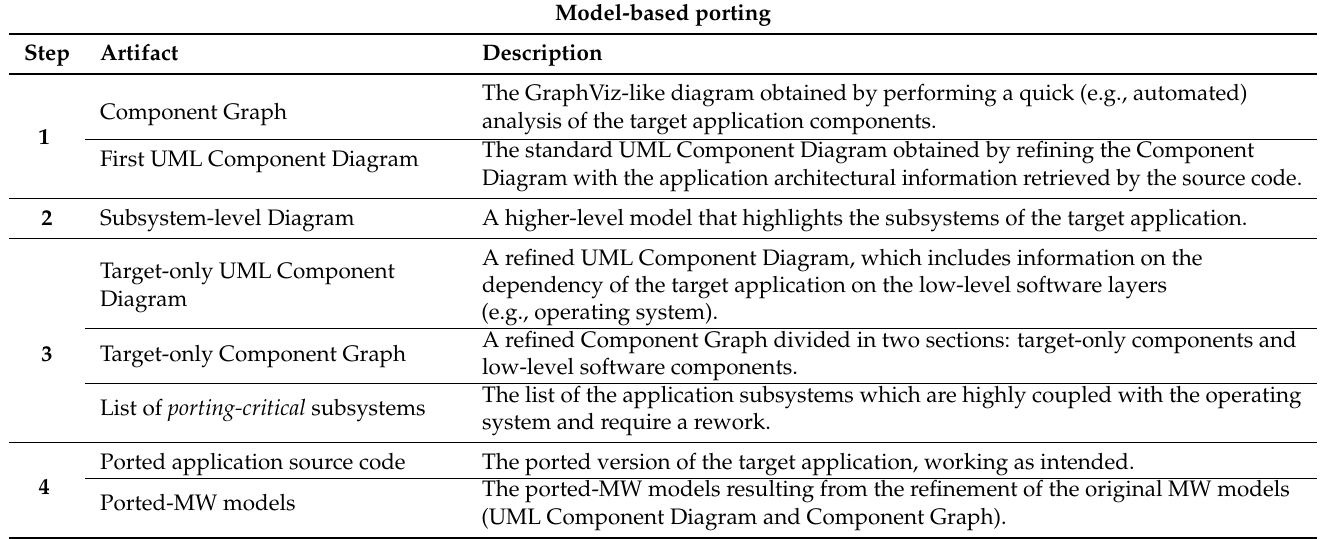
Table 3. Artifacts obtained at the output of all steps of our